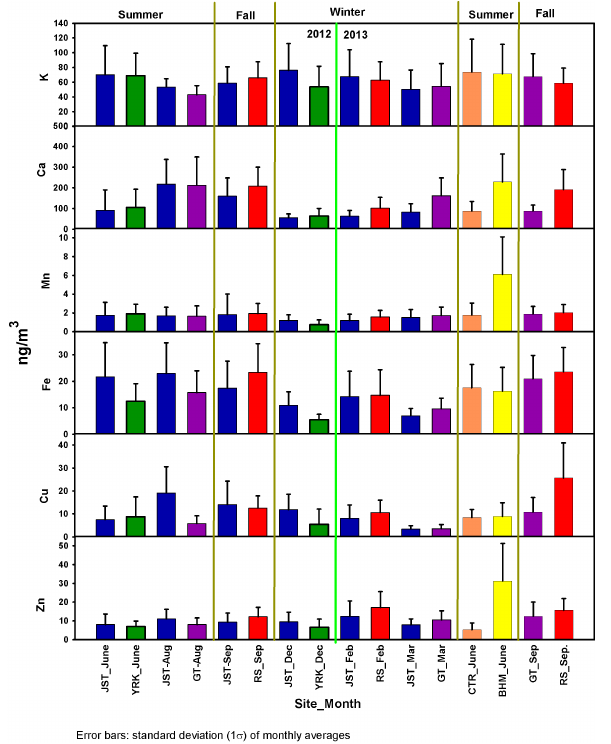
Figure 3. Monthly average ambient concentrations of water-soluble metals at the sampling sites.